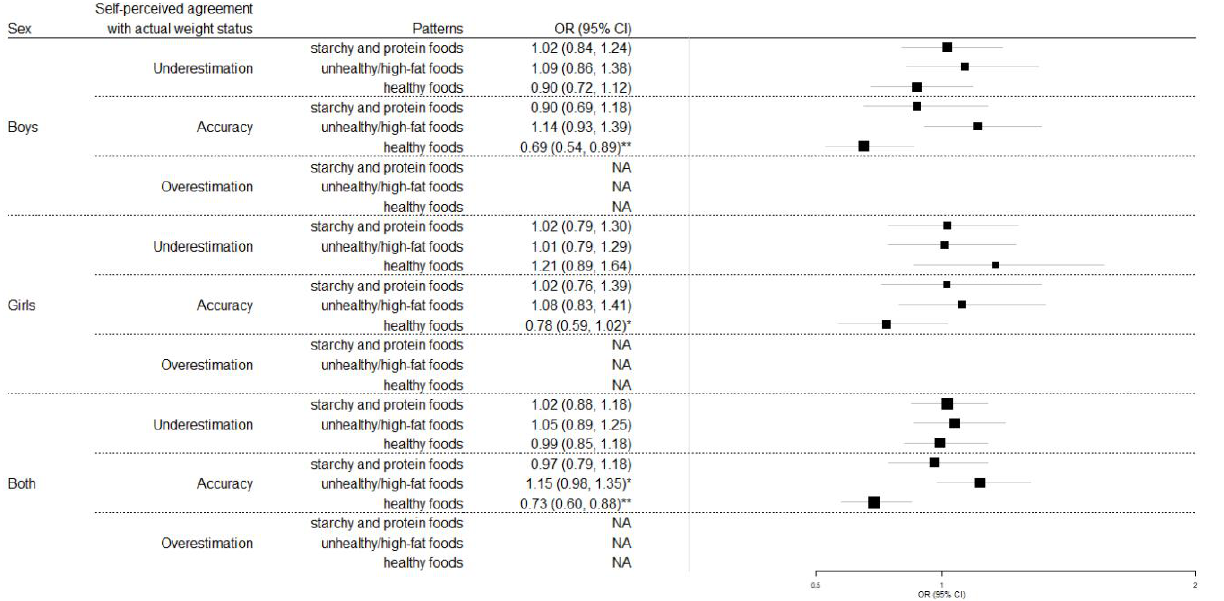
Figure 2. Results from multiple logistic regression models that evaluated the association between children’s dietary patterns and their obesity status, by self-perceived agreement with actual weight status. * p < 0.1, ** p < 0.05. NA: Logistic regression is not applicable as all children are categorized as normal-weighted, given that children with obesity/overweight cannot overestimate their weight status.